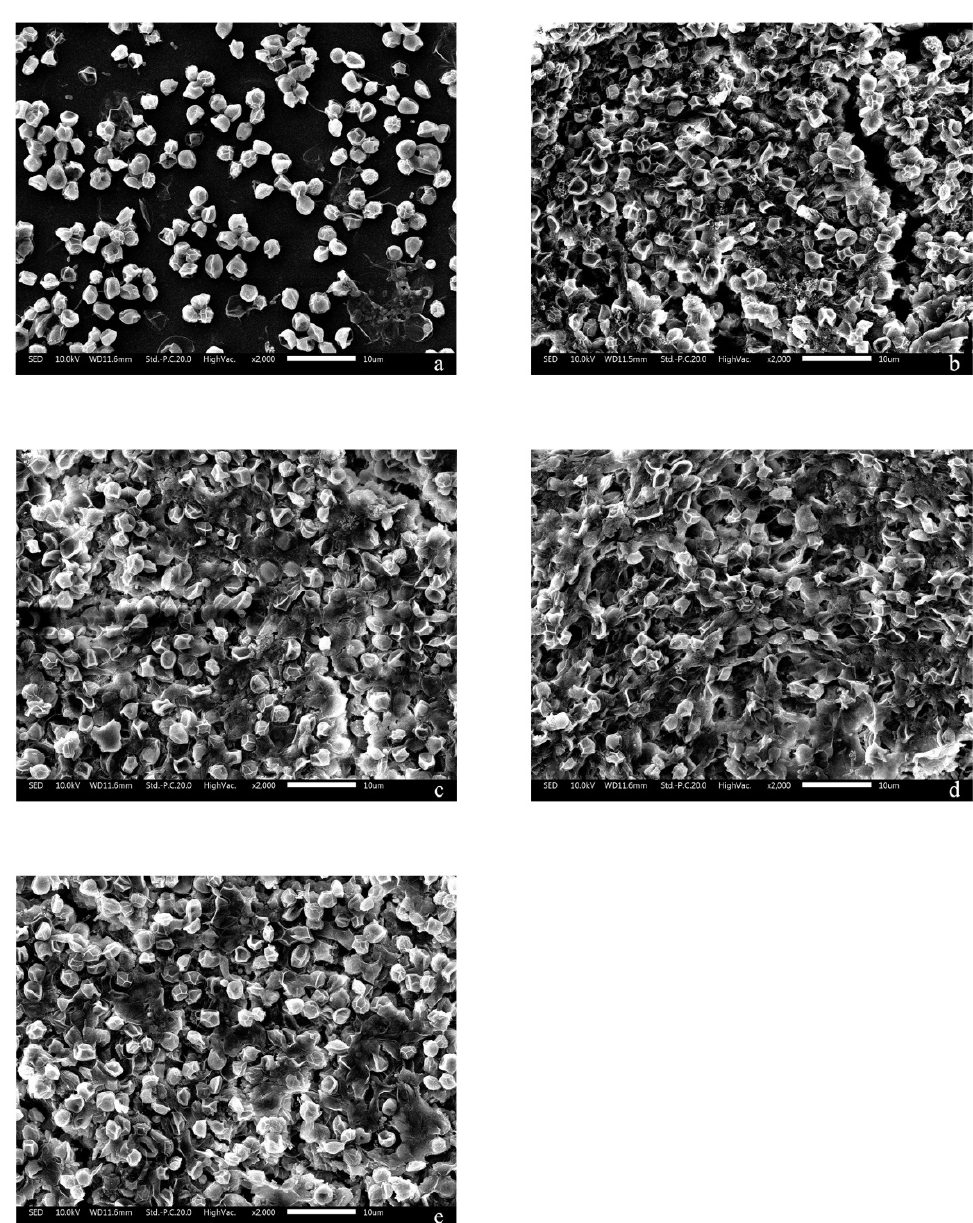
Figure 4. Scanning electron microscopy images of C. vulgaris ( a ) raw, ( b ) Al 2 (SO 4 ) 3 , ( c ) AlCl 3 , ( d ) Fe 2 (SO 4 ) 3 , and ( e ) FeCl 3 .